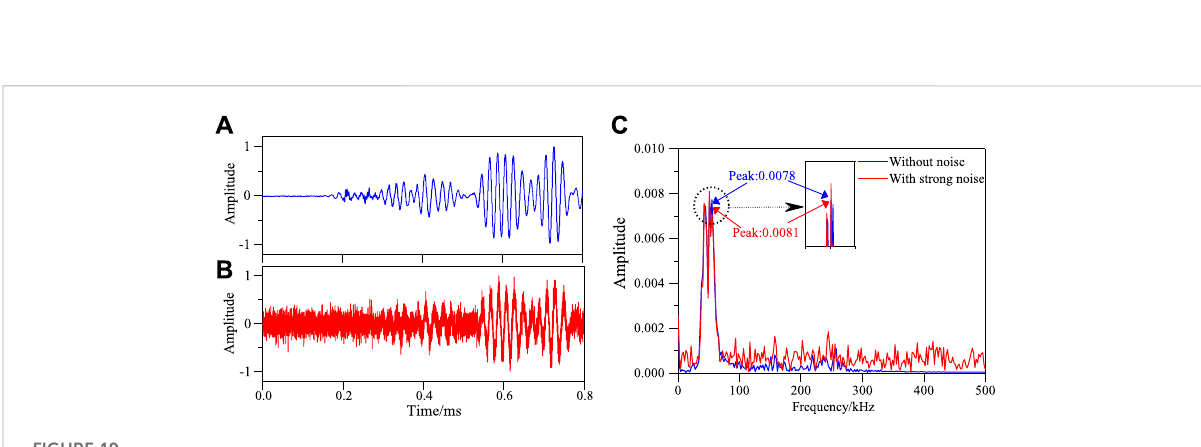
FIGURE 19 Frequency spectrum of S1 – S7 sensing channel damage in structure under strong noise environment. (A) Effective signal-damaged. (B) After adding 3 dB with noise. (C) Frequency spectrum of S1 – S7 signal sensing channel.